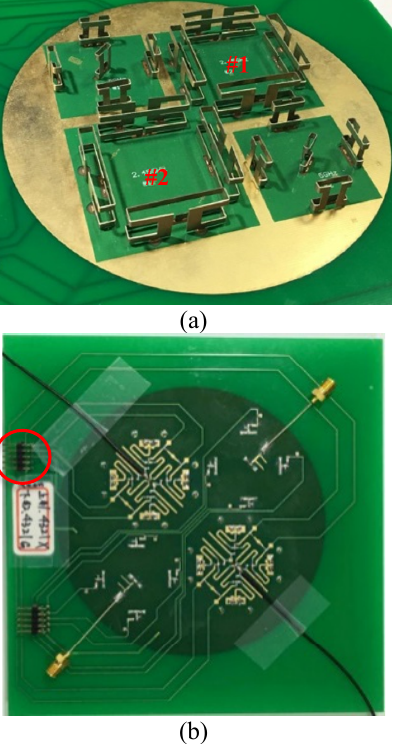
Figure 14: Photographs of the fabricated dual-band MIMO antenna: (a) top view and (b) back view